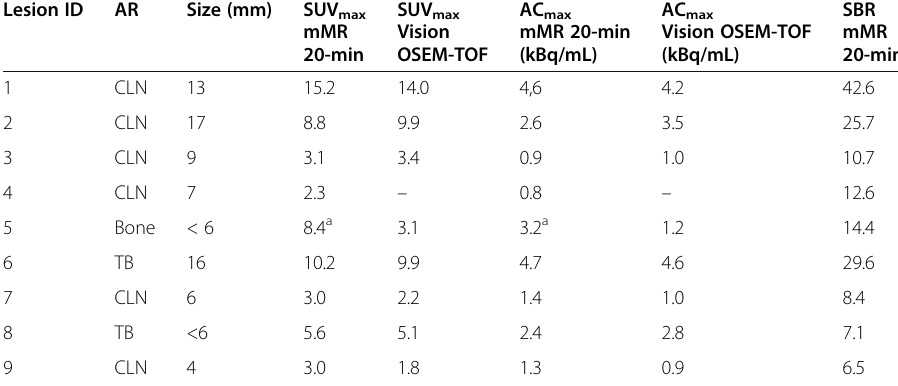
AR Anatomical region, CLN Cervical lymph node, TB Thyroid bed, SBR Signal-to-background ratio (only reported for the 20-min acquisition on the mMR, in which all lesions were